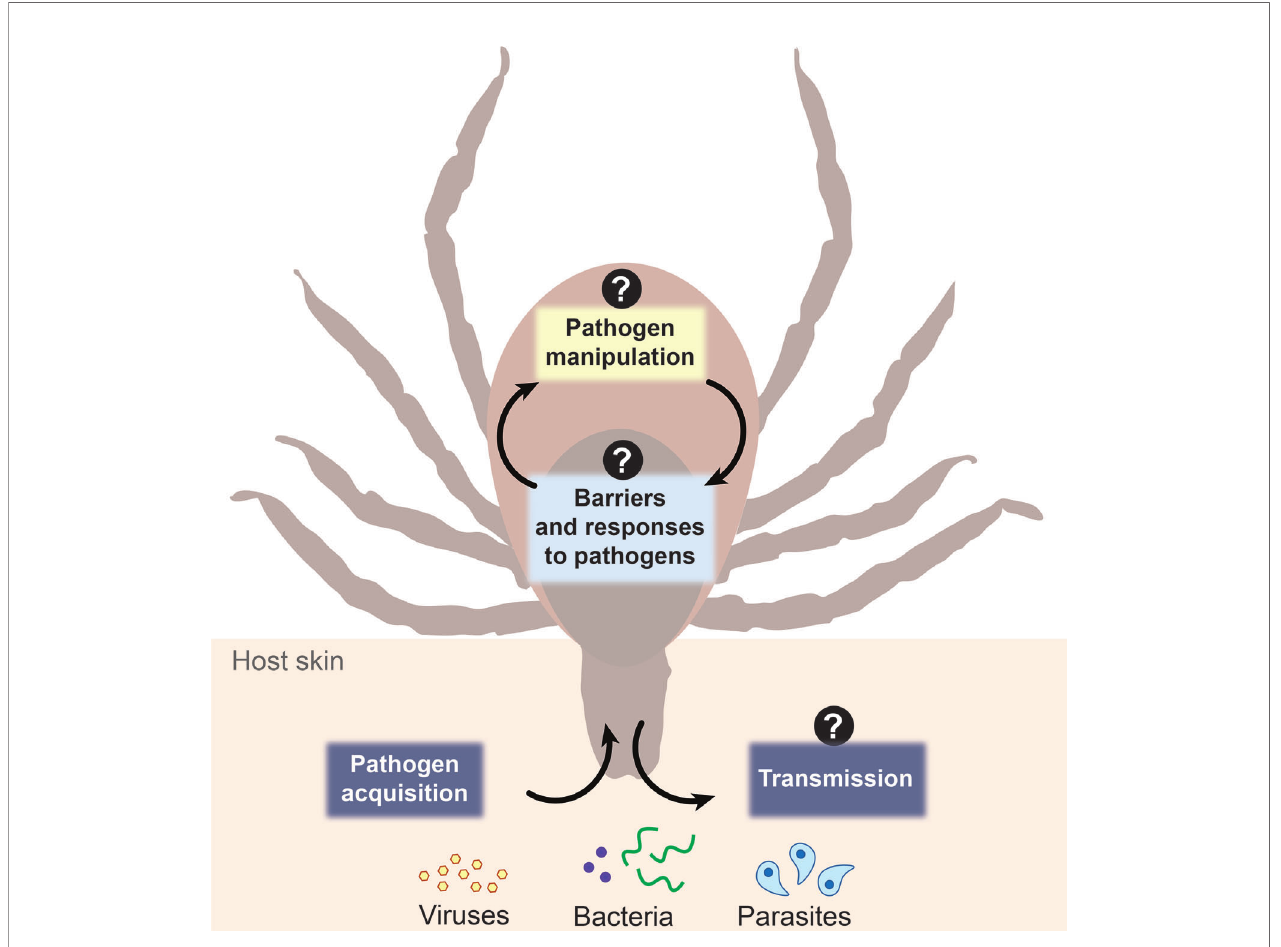
FIGURE 1 | Schematic representation of three aspects of tick-microbe interactions. The vector-side of tick-borne disease is open for discovery. Question marks represent topics in the fi eld that remain incompletely understood including arthropod barriers to colonization and responses to pathogens, how microbes manipulate the arthropod to colonize and survive within the tick, and what the role and composition of salivary secretions are during pathogen transmission